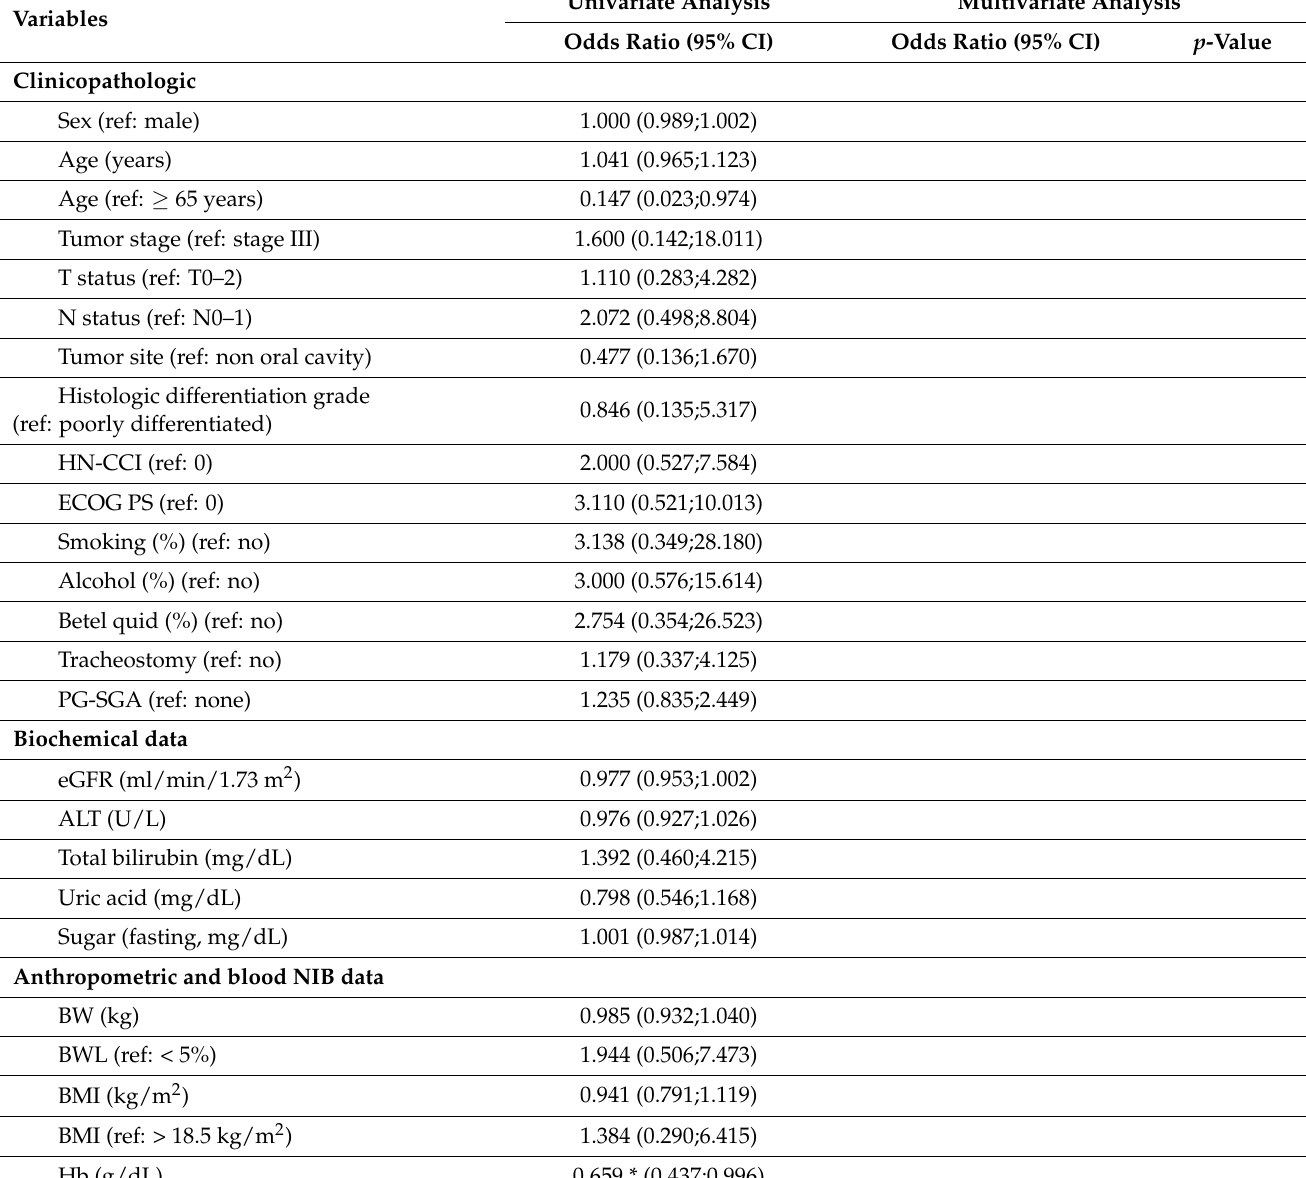
Table 3. Univariate and multivariate logistic regression analysis of prognostic factors associated with 3-year mortality rate of 50 patients with